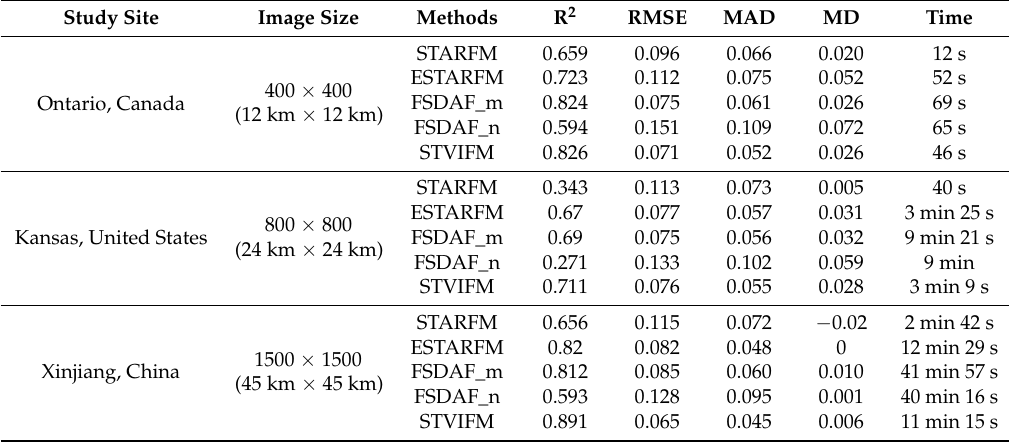
Table 3. Statistical parameters of the linear regression analysis between synthetic and original Landsat NDVI